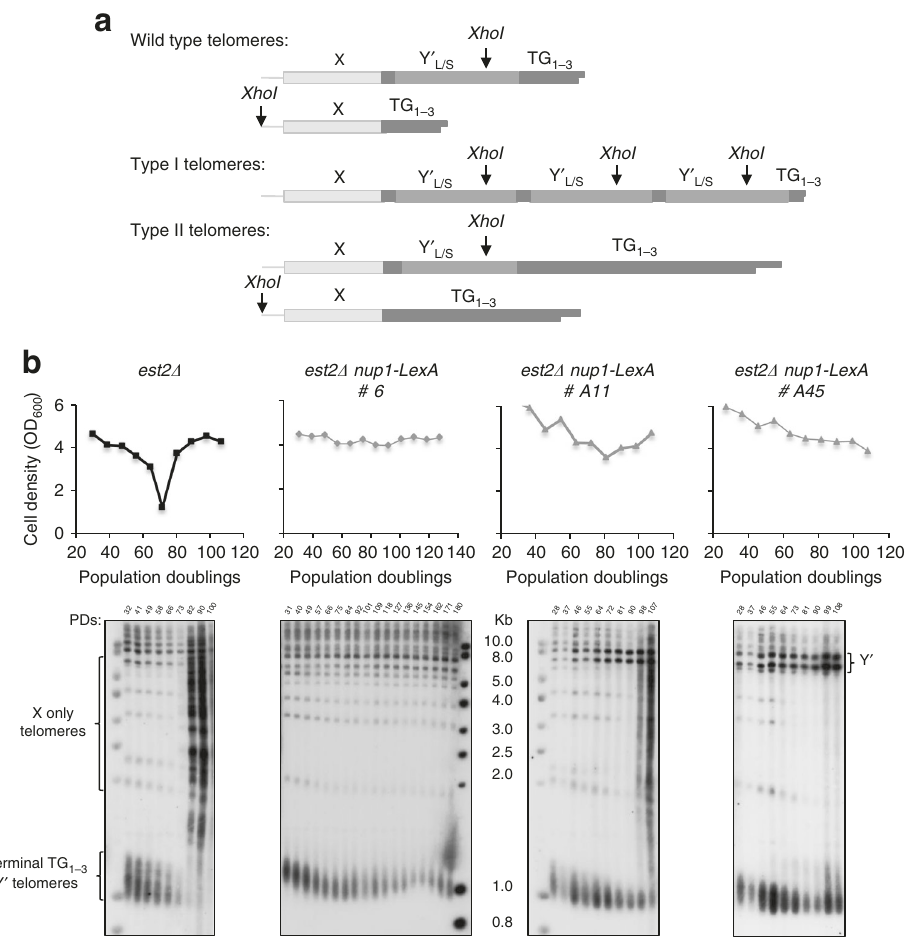
Fig. 4 Telomere length is maintained at a minimal length in nup1-LexA cells. a Schematic representation of wild-type, type I and type II telomeres. All telomeres contain one X element in the subtelomeric region. In addition, about two-third of the telomeres contain from one to four long (L) or short (S) subtelomeric sequences called Y ′ separated by short interstitial TG 1 – 3 repeats, both being ampli fi ed in type I survivors. Positions of the XhoI sites are shown. b Senescence pro fi les of one est2 Δ clone (black) and three independent representative est2 Δ nup1-LexA clones (gray). Telomere length and survivor formation in the same replicative senescence experiment were monitored by TG 1 – 3 probed Southern blots of XhoI -digested